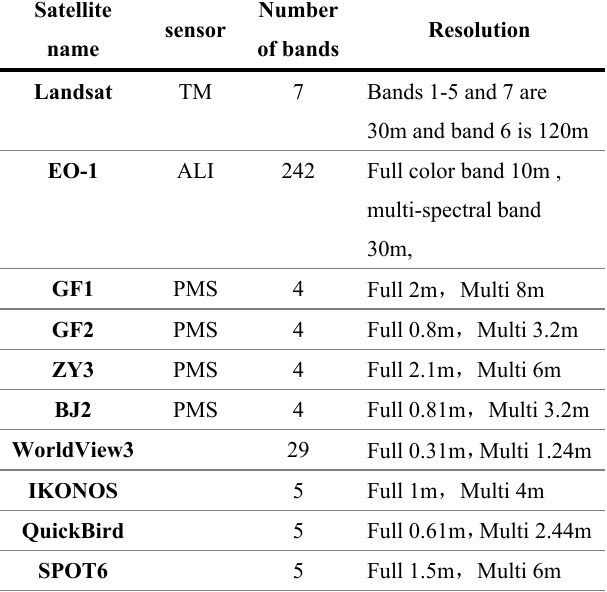
Table 1. C haracteristics of some remote sensing satellite image The first-level imaging products are equipped with